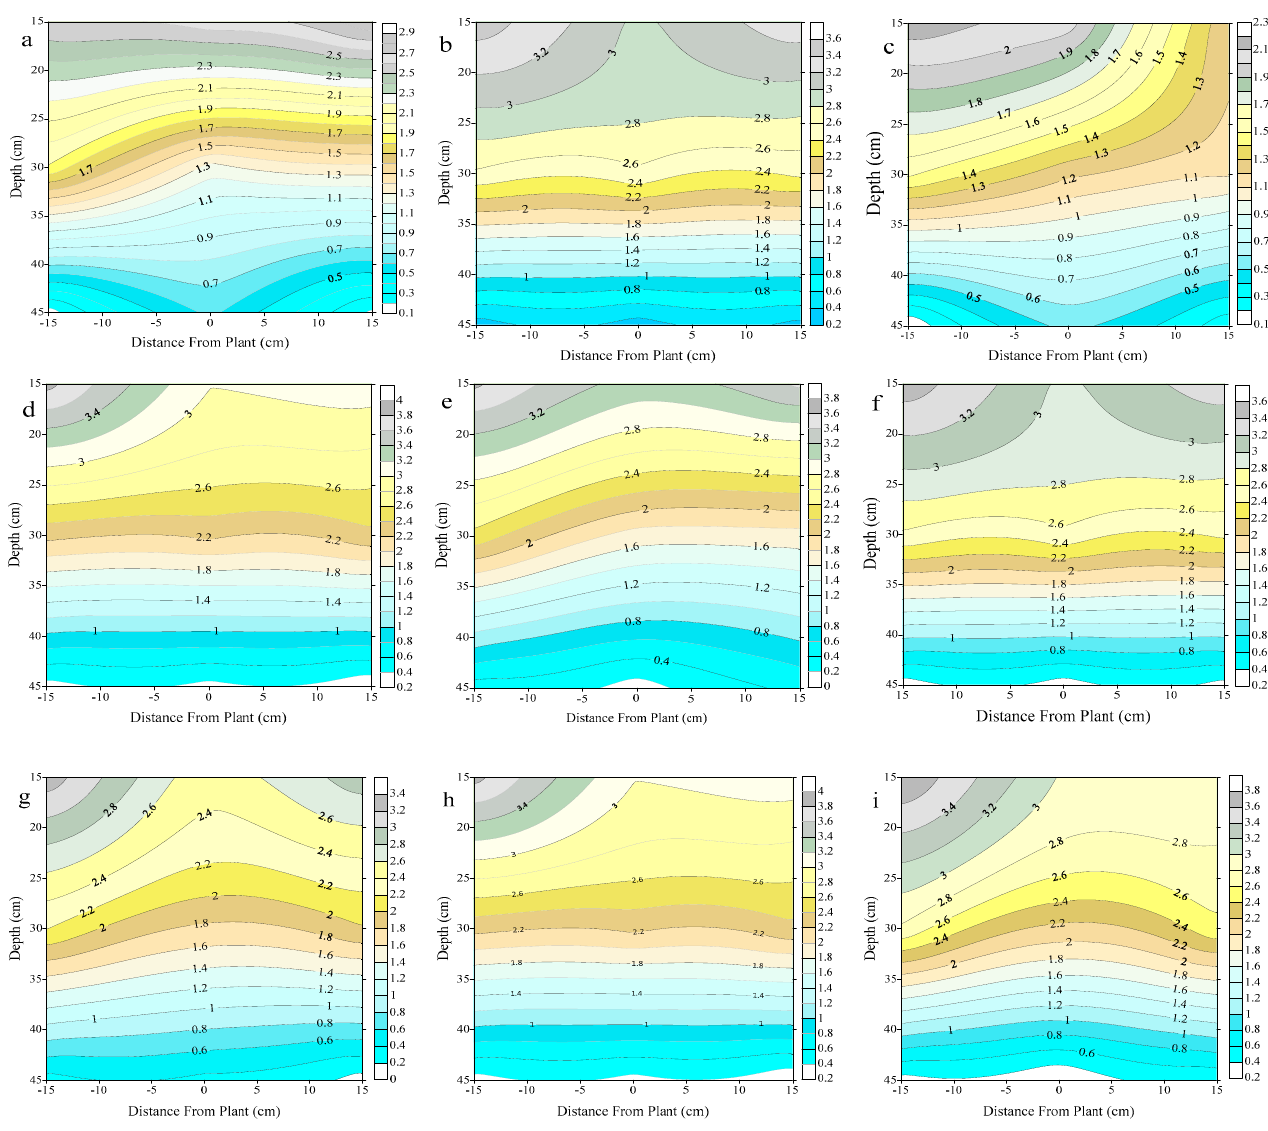
Figure 4. Salinity distribution after amending the soil with biochar and irrigating with saline